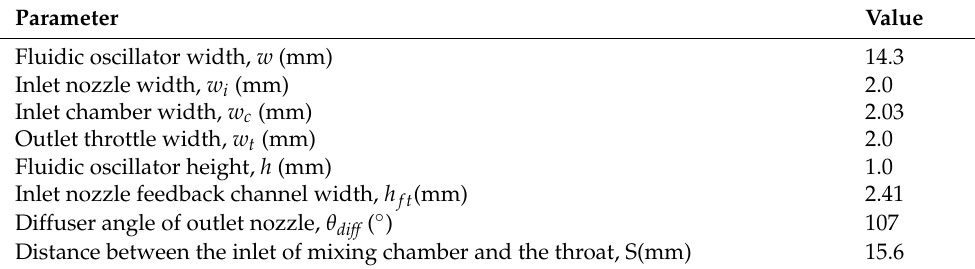
Table 1. Geometrical parameters of the fluidic oscillator tested.